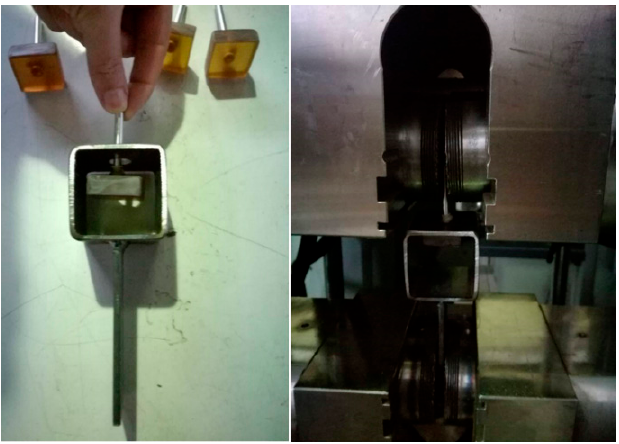
Figure 4. Pullout tests of friction-riveted joints.